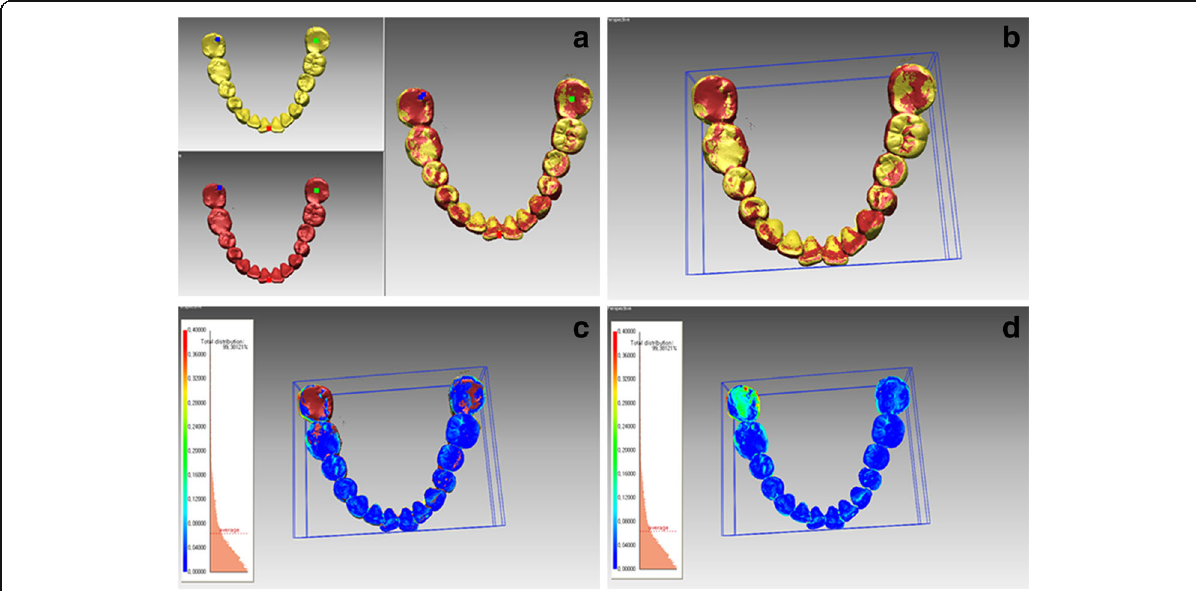
Fig. 1 Registration of the three-dimensional models created by iTero (yellow) and TRIOS (red). a Initial registration by three corresponding points on each of the two models. b Automatic fine registration for final registration. c Computation of average deviations between the two intraoral scans at all points on the surfaces. d Color-coded charts for qualitative evaluation